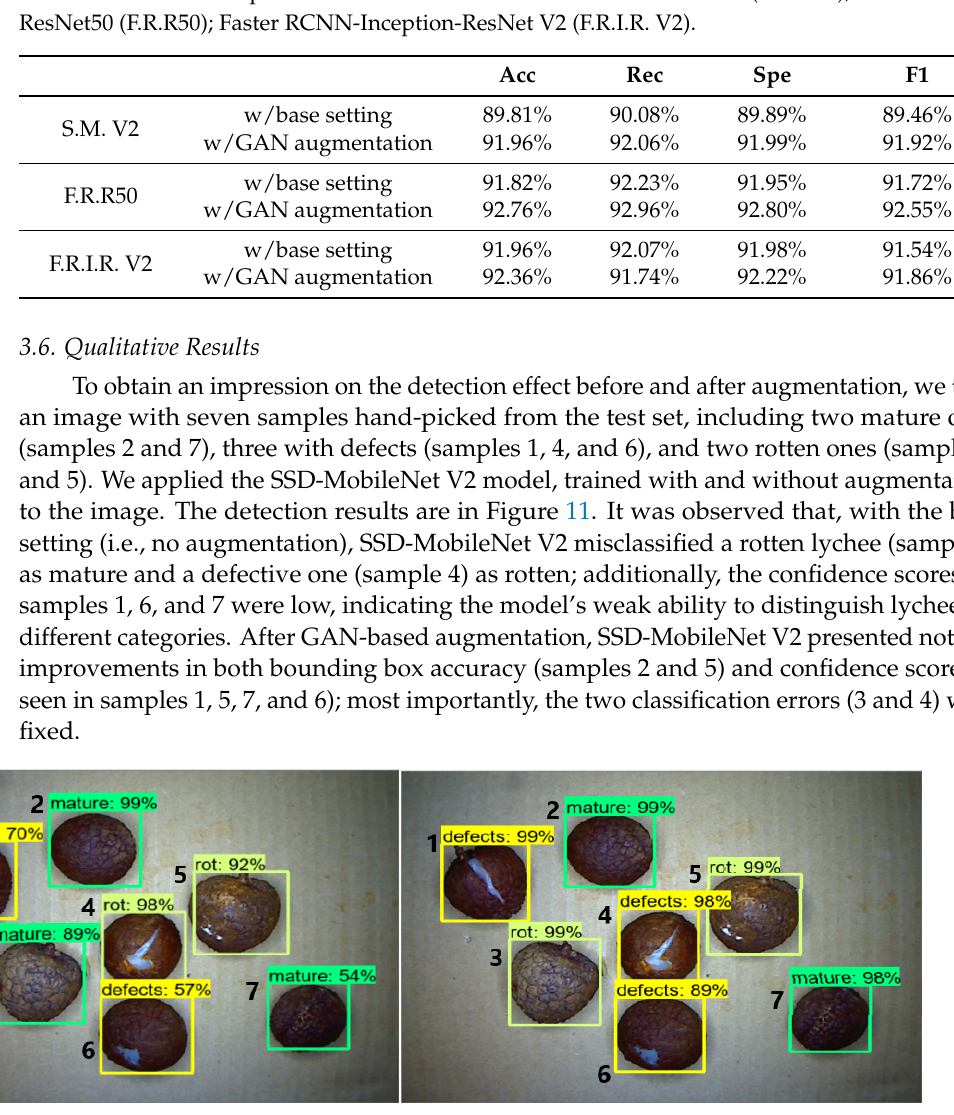
Table 2. Classification performance. Abbreviations: SSD-MobileNet V2 (S.M. V2); Faster RCNN-